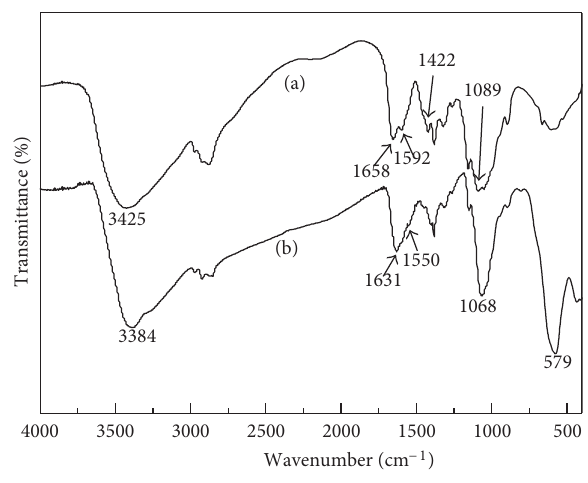
F 5: XRD patterns of the pure CS (a) and the composite (b) microcapsules.